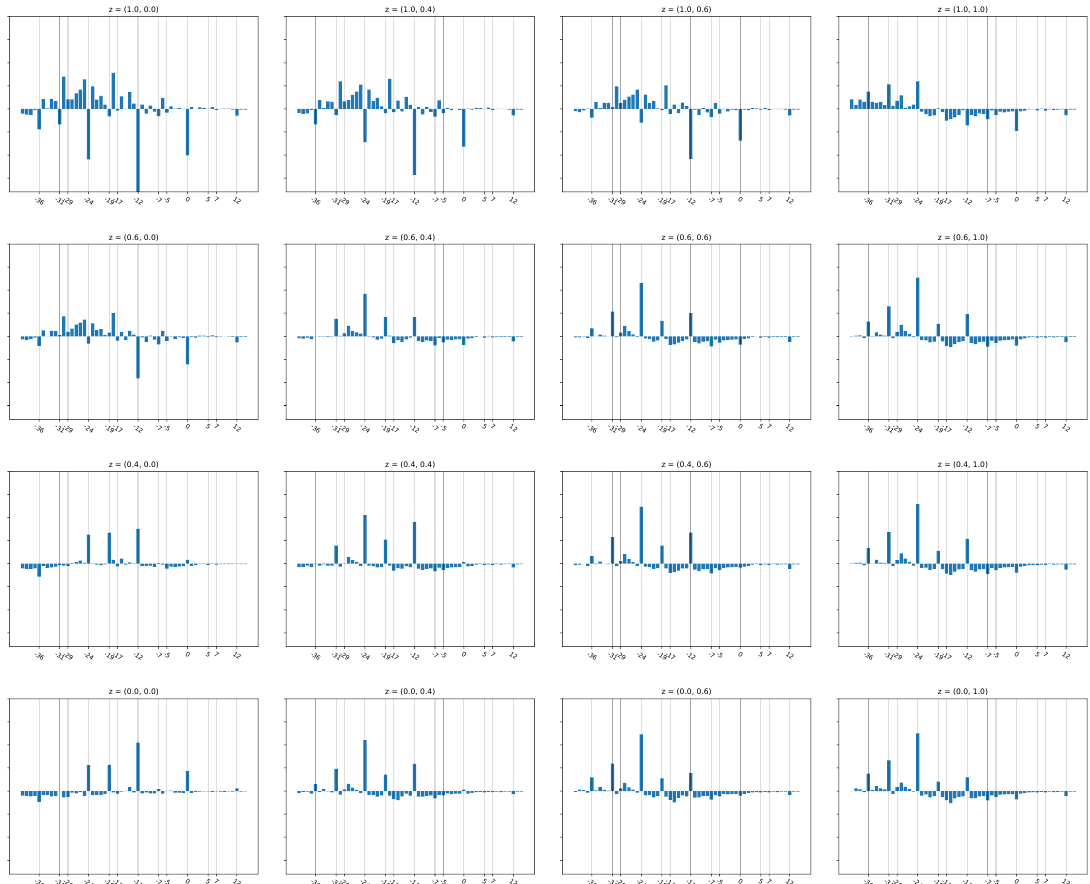
Figure 8. Relative f 0 distributions of generated bass tracks with respect to the f 0 of the mix, for different values of z . The pitch intervals on the horizontal axis are expressed in semitones. The scale of the vertical axis is arbitrary but identical across